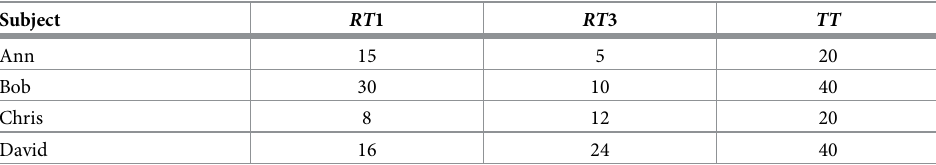
Table 2. Response times of four fictional subjects in the task